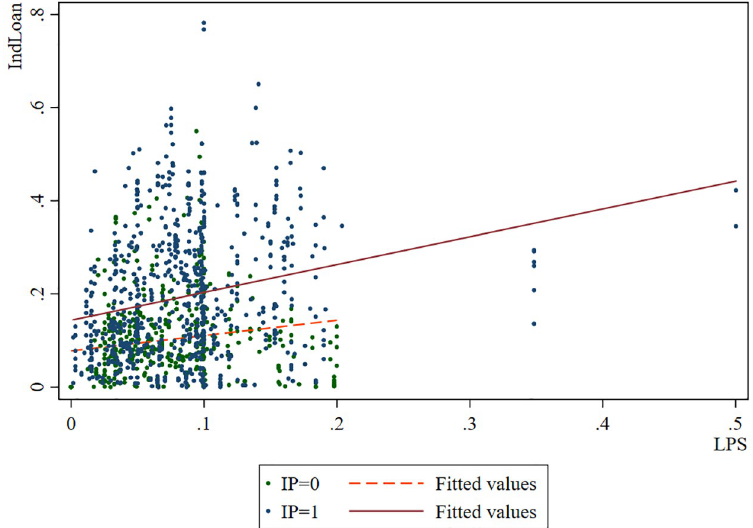
Fig 2. The shareholding of large private shareholders, local industrial policies and banks’ industry